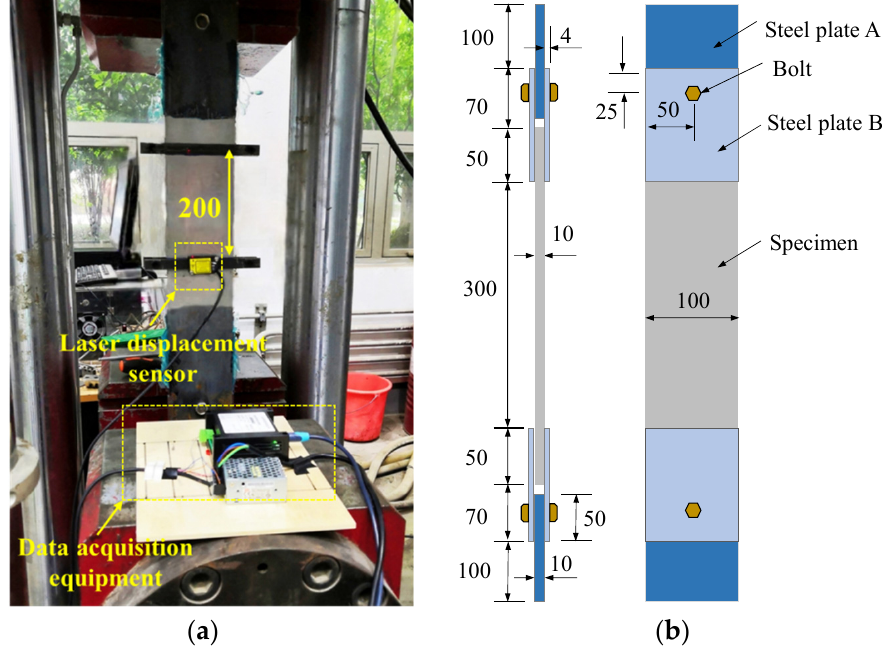
Figure 5. Tensile test set-up and specimen dimensions (unit: mm): ( a ) tensile test set-up; ( b ) specimen dimensions.